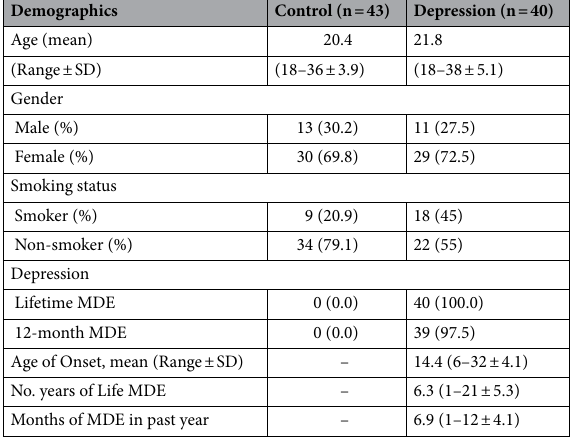
Table 1. Sample demographics based on participant response to CIDI depression